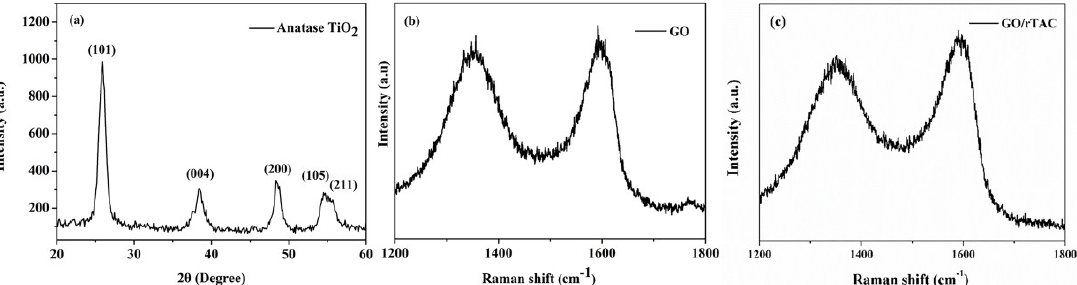
Figure 1. ( a ) X-ray diffraction pattern of TiO 2 nanoparticles; Raman spectra of ( b ) pure graphene oxide (GO) and ( c ) GO/rTAC after electrophoretic deposition, shown for comparison.